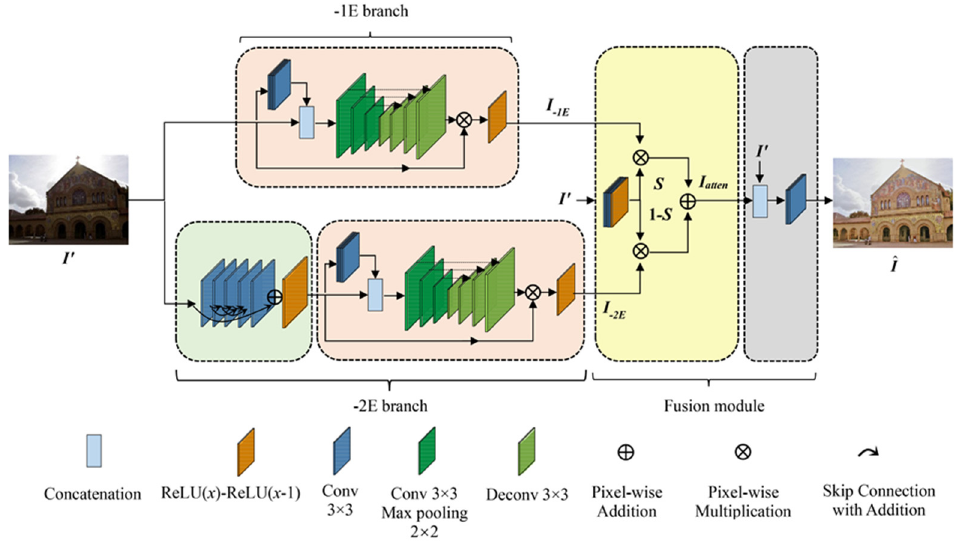
Figure 4. The network architecture of a low-light image enhancement model [35].